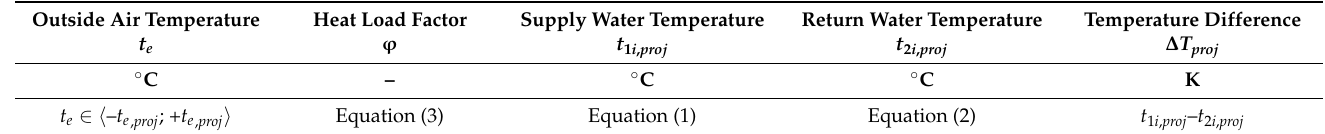
Table 3. Table of supply and return temperatures distribution of the central heating installation in design